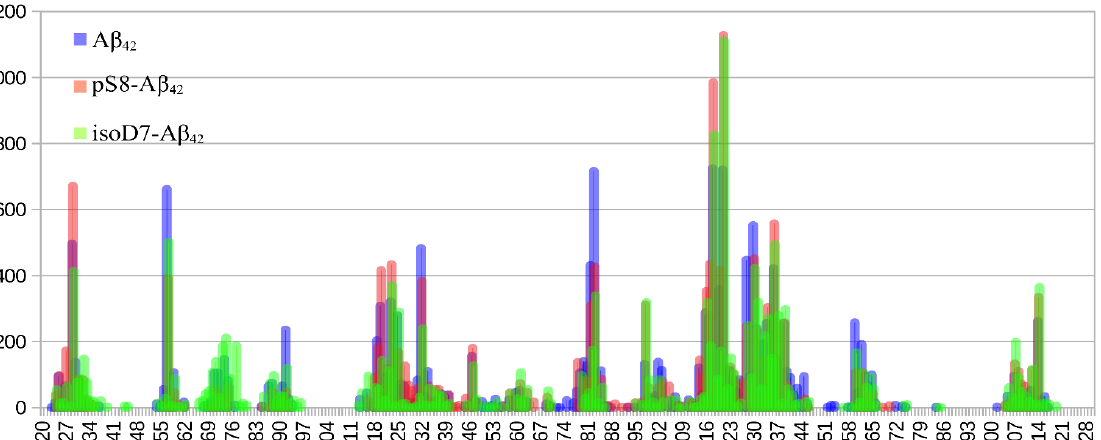
Figure 5. Joint contact frequency histograms for targeted docking of Aβ 42 isoforms to Interface 1 and Interface 2 of the RAGE protein performed with PatchDock server and analyzed by QASDOM software. A total of 30 best complexes with each isoform were used for the analysis.